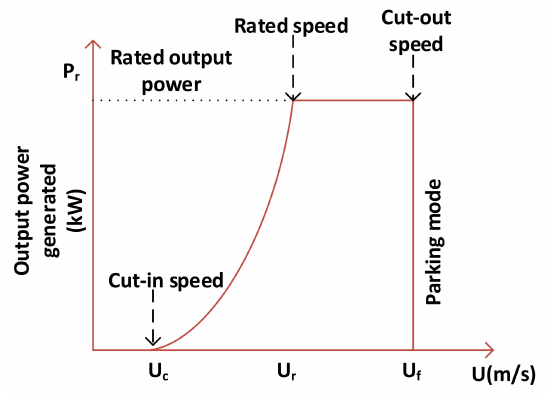
Figure 4. Wind turbine output power characteristics